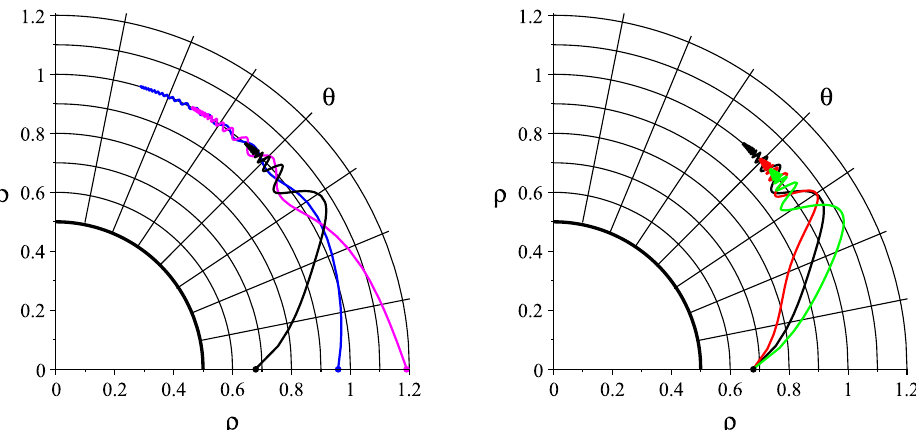
(cid:0) (cid:1) (cid:26) ( t ) ; (cid:18) ( t ) for the same values of the constants as in (cid:12)gure 10. The